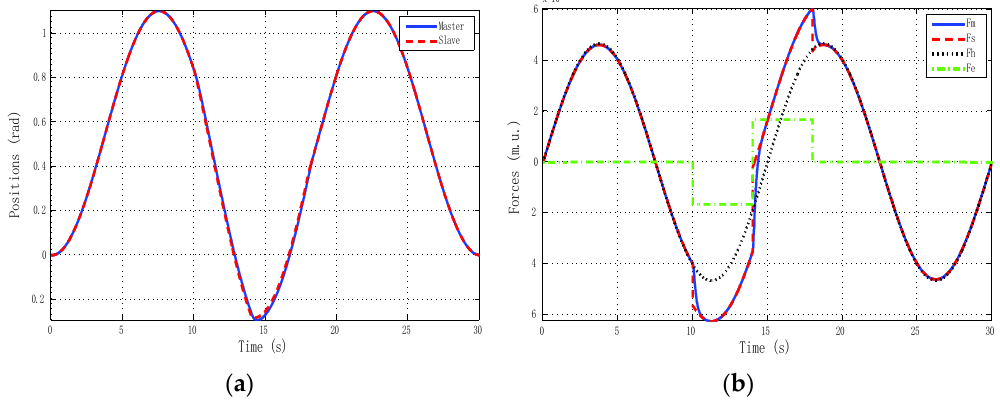
Figure 7. Simulated sine reference force: 3C-ii control scheme with h max = 0, d = 0. ( a ) Positions; ( b ) Forces.